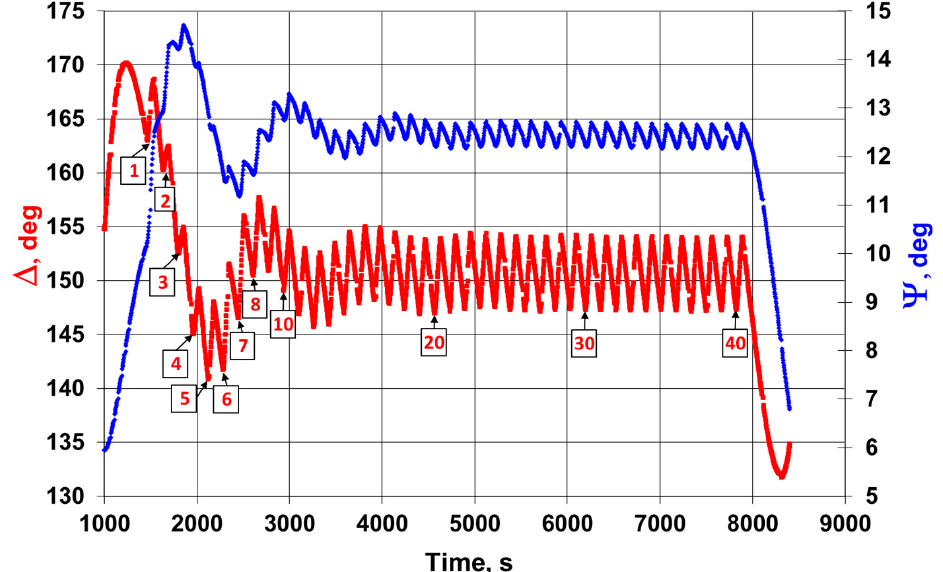
Figure 1. The change of the ellipsometric parameter Δ (red) and ψ (blue) measured in situ vs. time during 40 periods of the MQW growth. The numbers show the period of the barrier and well pair growth.